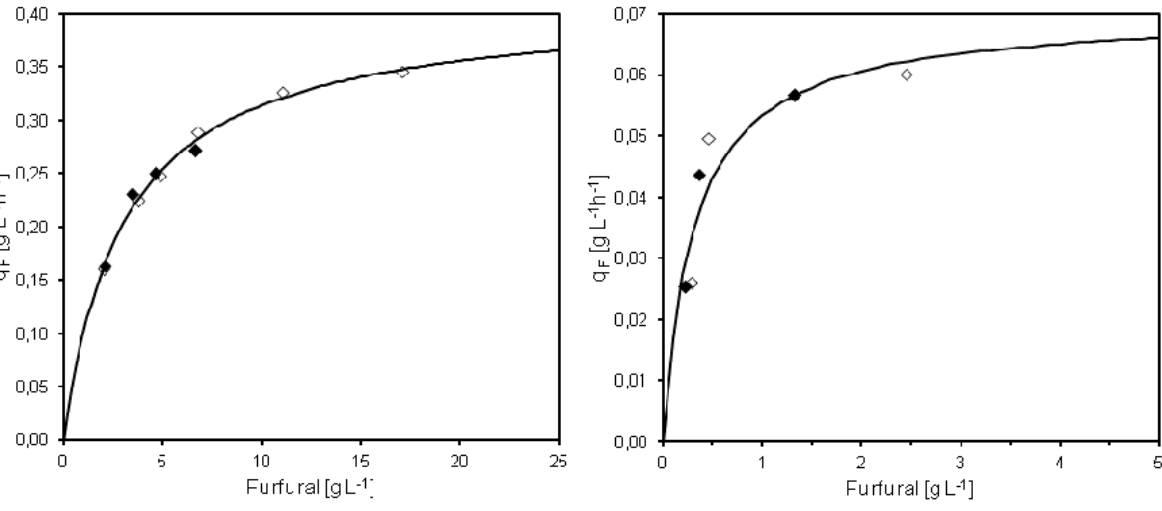
Figure 5. Summary of the specific conversion rate of furfural (q pulse injection (left) or continuous (right) furfural addition. The q cultivations are presented together with the regression curve calculated based on Michaelis-Menten kinetics. Open/closed symbols denote separate